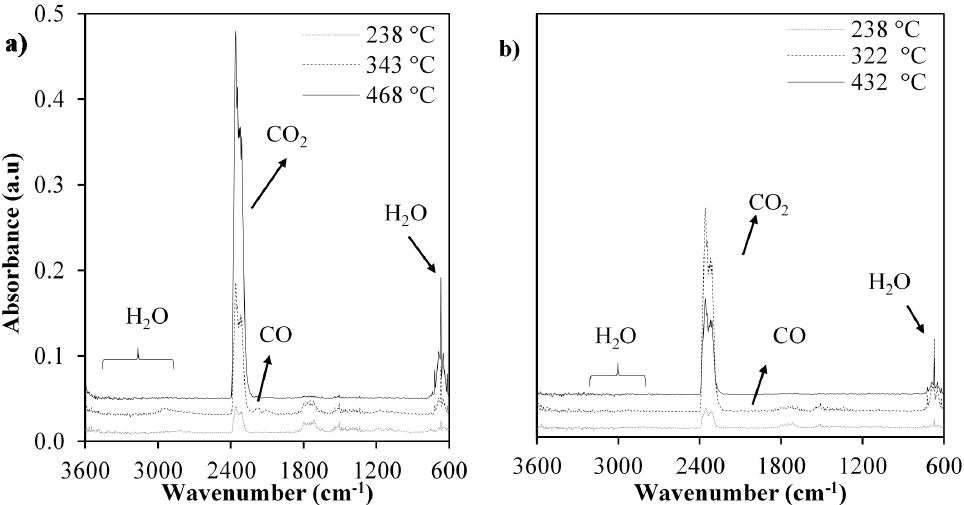
Figure 4. FTIR spectra obtained at the maximum decomposition rates during combustion of ( a ) biomass and ( b ) biomass/catalyst 1:1 at 10 °C min − 1 . Catalyst: Rh-Pt/CeO 2 -SiO 2 .